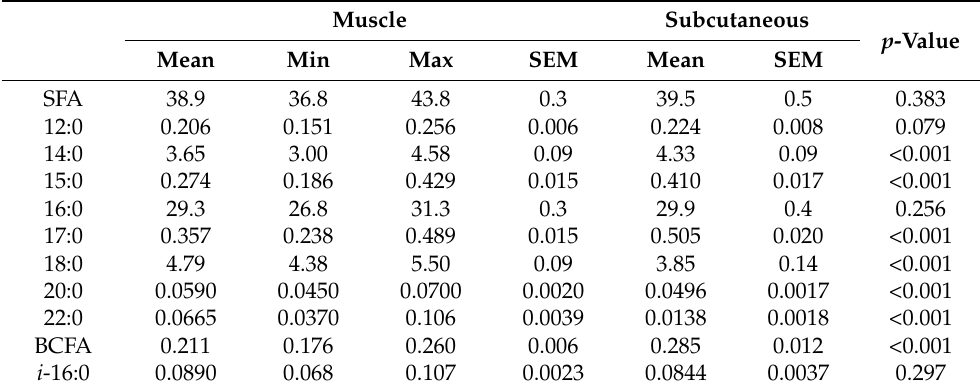
Table 2. Effect of fat tissue (muscle and subcutaneous fat) on the saturated and branched-chain fatty acid composition of horse meat in percentage basis (%) ( n =